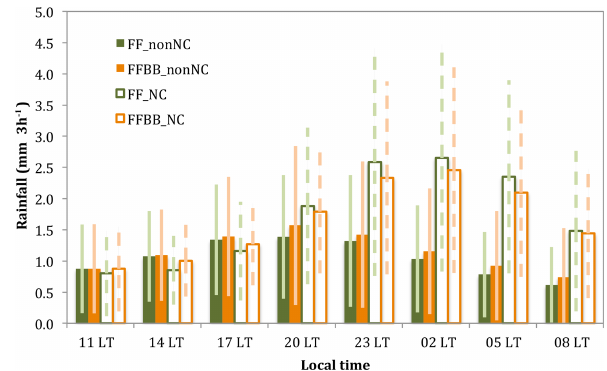
Figure 10. The diurnal time series of rainfall averaged over the Bor- neo region (r2) for nocturnal convections (NC) and non-nocturnal convections (non-NC) during fire periods in FF and FFBB. The er- ror bars denote the standard deviation of the